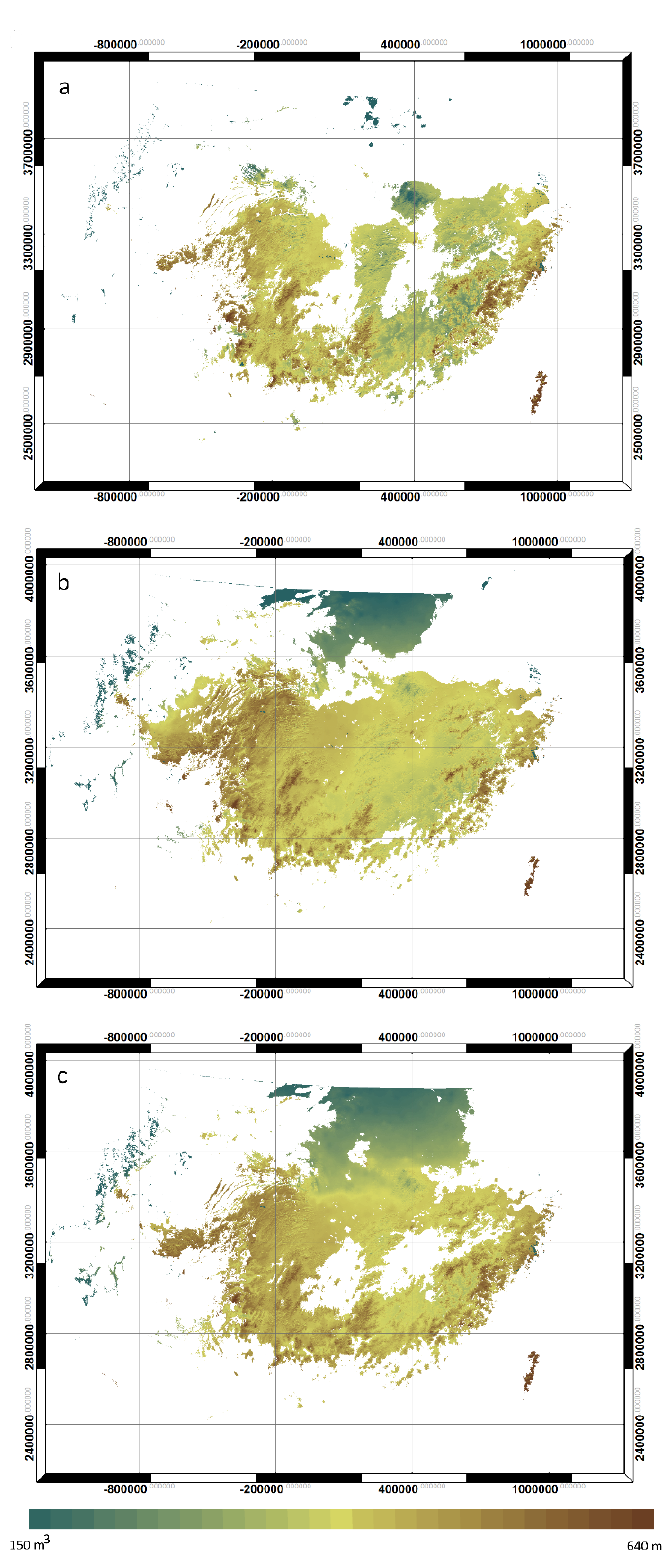
Figure 7. Volume (m 3 /ha) at age of 20 years, predicted by 3-PG; ( a ) current climate; ( b ) A1B projection; ( c ) A2